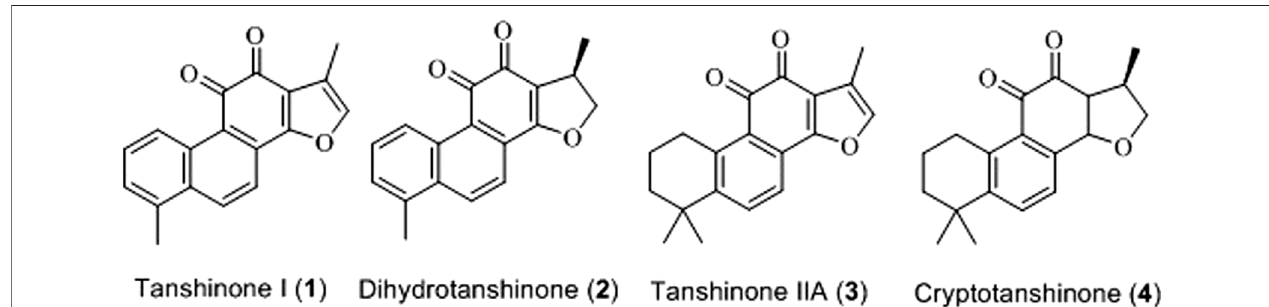
FIGURE 1 | The chemical structure of tanshinone ( 1 – 4 ).